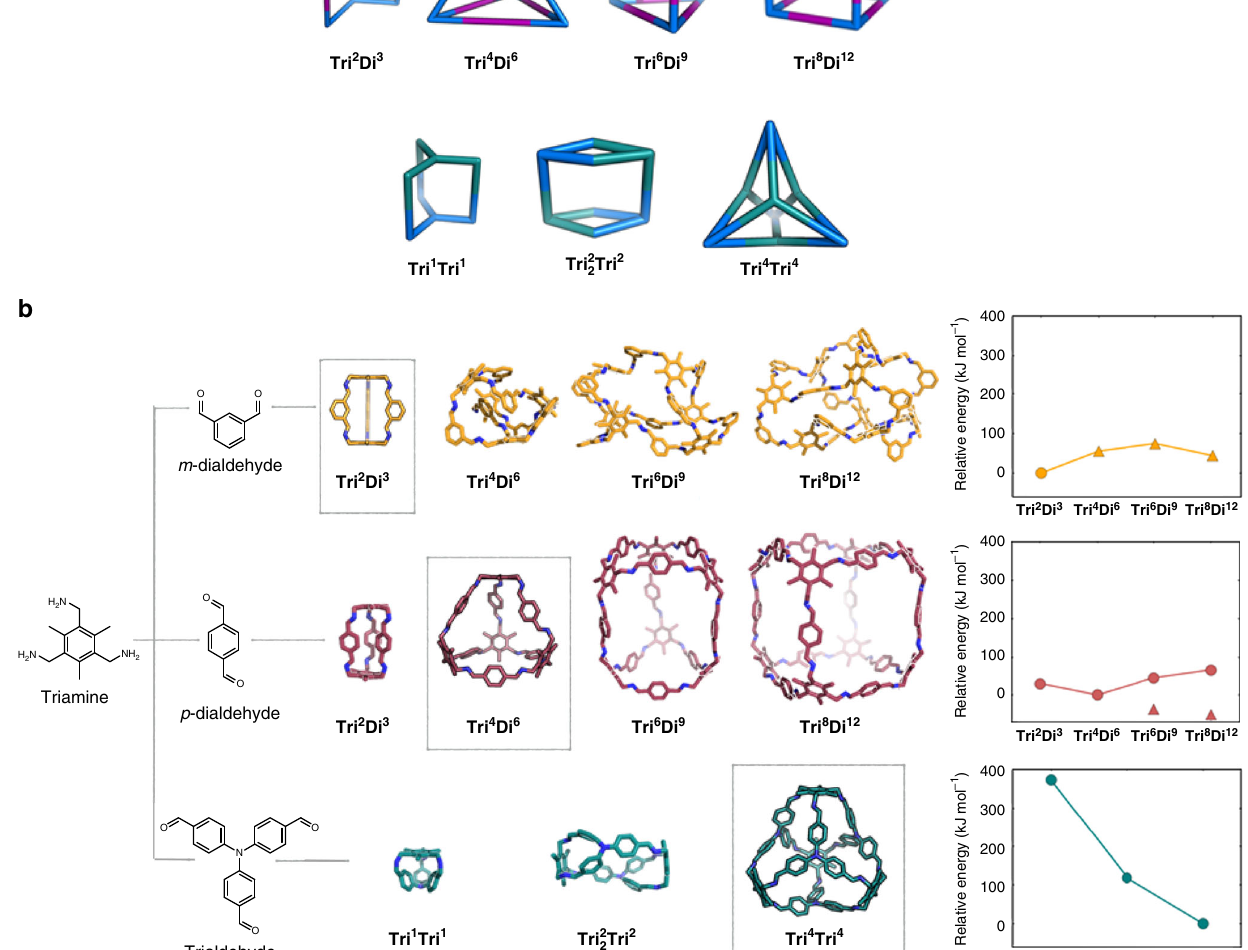
Fig. 2 Reaction schemes and computational modelling for three model covalent organic cages. a Scheme showing possible cage topologies; (top) candidate topologies for tritopic + ditopic reactions ( Tri x Di y ) and (bottom) for tritopic + tritopic reactions ( Tri x Tri y ). Tritopic precursors are shown in blue or cyan, ditopic precursors in purple. b Computationally derived structures for the possible topological combinations of the tritopic triamine linker ((2,4,6- trimethylbenzene-1,3,5-triyl)trimethanamine), with m -dialdehyde (isophthalaldehyde), p -dialdehyde (terephthalaldehyde), and trialdehyde (tris(4- formylphenyl)amine), respectively. The energetically preferred topologies have a grey box around them. The plots (right) show the relative internal energies calculated for the different topologies, plotted on a common energy scale. For topologies where both collapsed and open conformations are computed, the energy of the collapsed conformation is indicated by a triangle symbol; open conformations are indicated by circle symbols. For the p - dialdehyde, only open conformations are shown in the images, collapsed Tri 6 Di 9 and Tri 8 Di 12 topologies are shown in Supplementary Fig. 1. Tri 2 Di 3 cages are shown with orange carbons, Tri 4 Di 6 with maroon, and Tri 4 Tri 4 with teal. All nitrogens are blue and hydrogens are